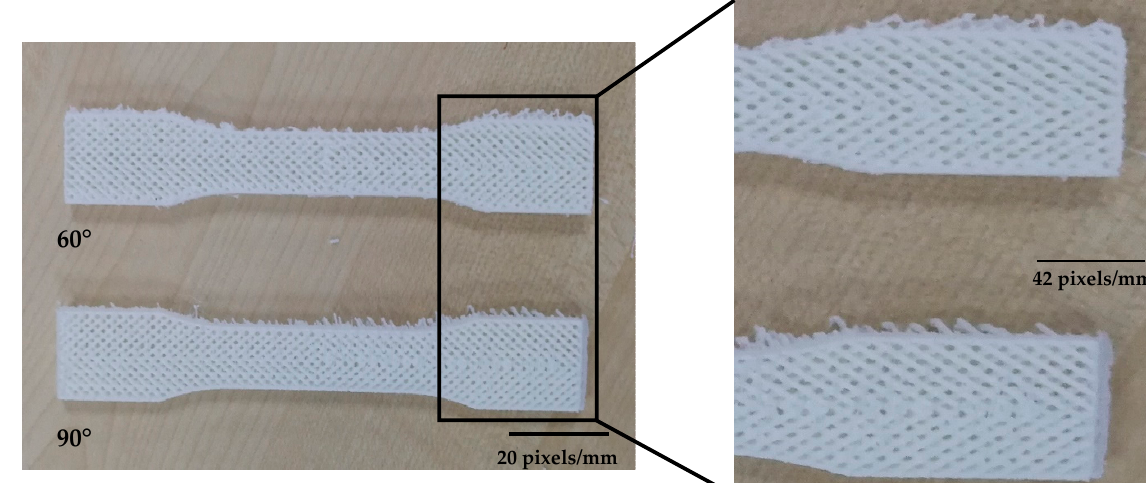
Figure 10. The quality of 60° and 90° on-edge samples.